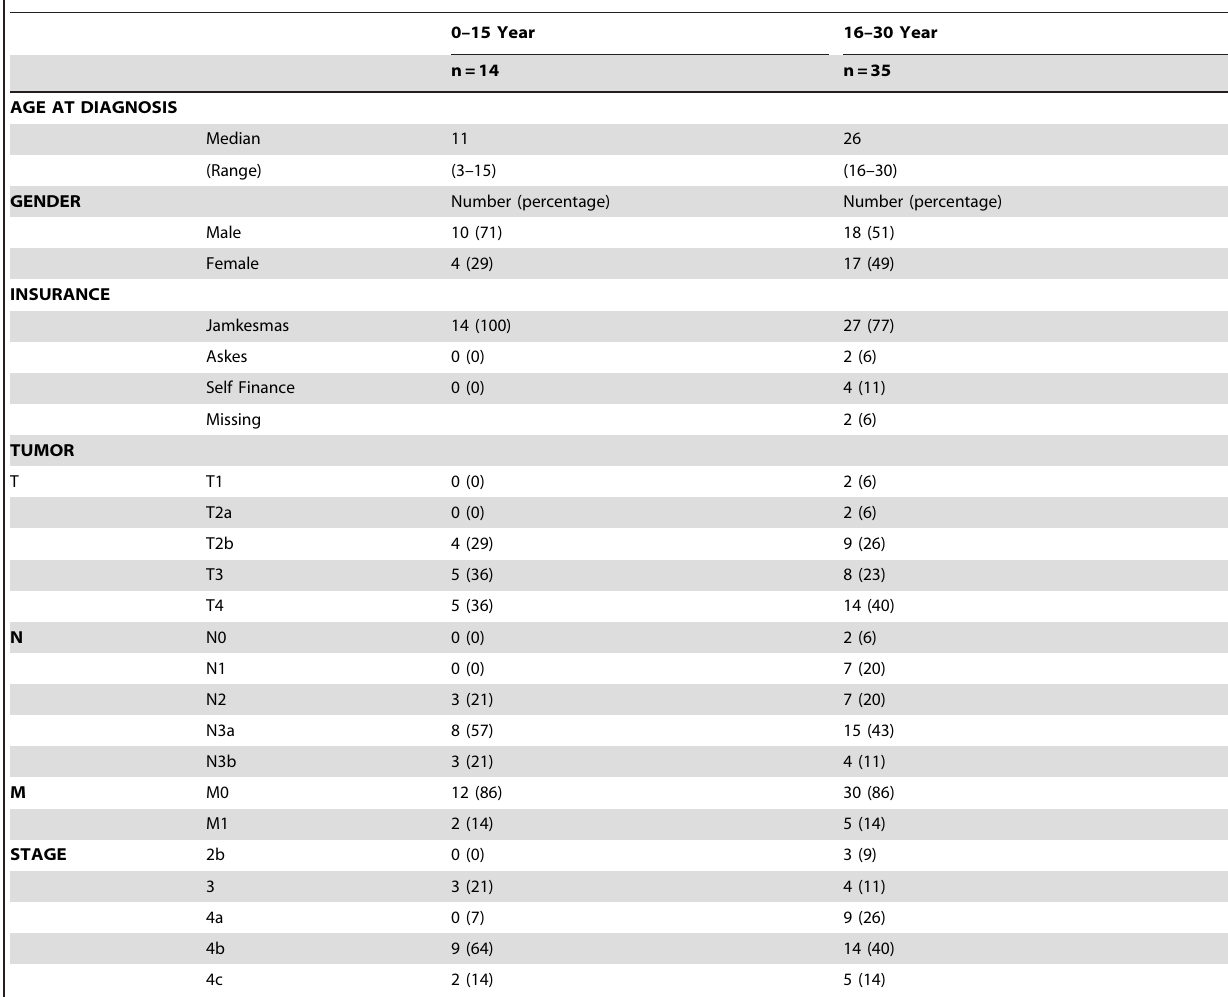
Table 1. Patient & tumor